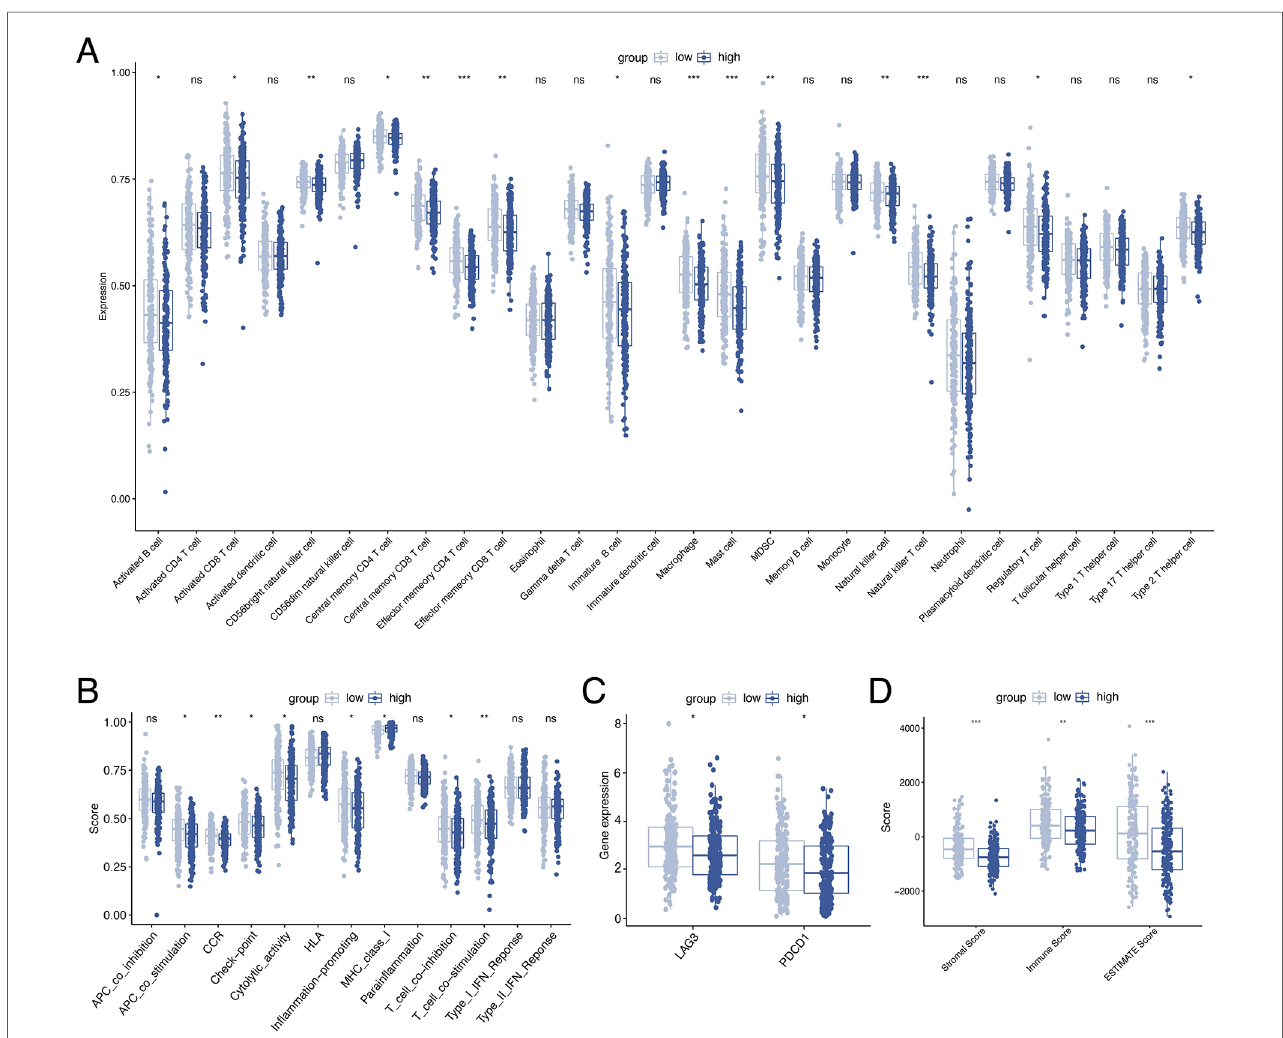
FIGURE 7 Analysis of immune activity. Comparison of the discrepancy of immune cell in fi ltration ( A ) and immune function ( B ) between two groups based on ssGSEA. ( C ) Differences in the expression of LAG-3 and PD-1 between the two groups. ( D ) TME analysis based on the ESTIMATE algorithm. ssGSEA, single-sample gene set enrichment analysis. TME, tumor